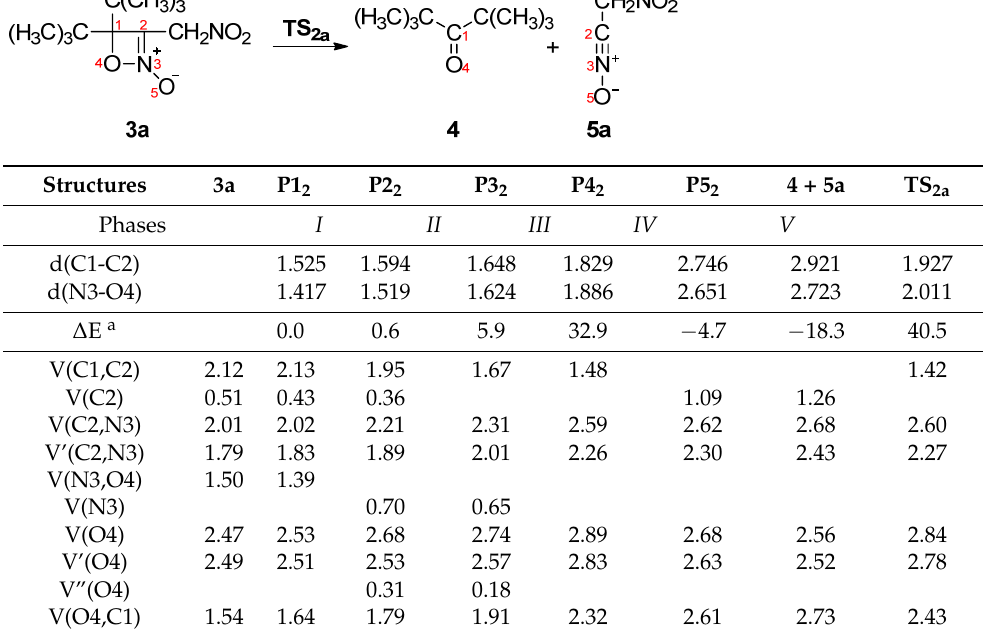
Table 3. ELF valence basin populations, distances of the forming bonds, MPWB1K/6-311G(d,p) relative a electronic energies ( ∆ E) of the IRC structures, P1 2 – 4 + 5a , defining the five different topically phases retro-32CA of the 4,4-di-tert-butyl-3-nitromethyl-4H-[1,2]oxazete 2-oxide ( 3a ). 3a , TS 2a , and products 4 and 5a are also included. Distances are given in angstroms, Å, electron populations in average number of electrons, e, and relative energies in kcal · mol − 1 .